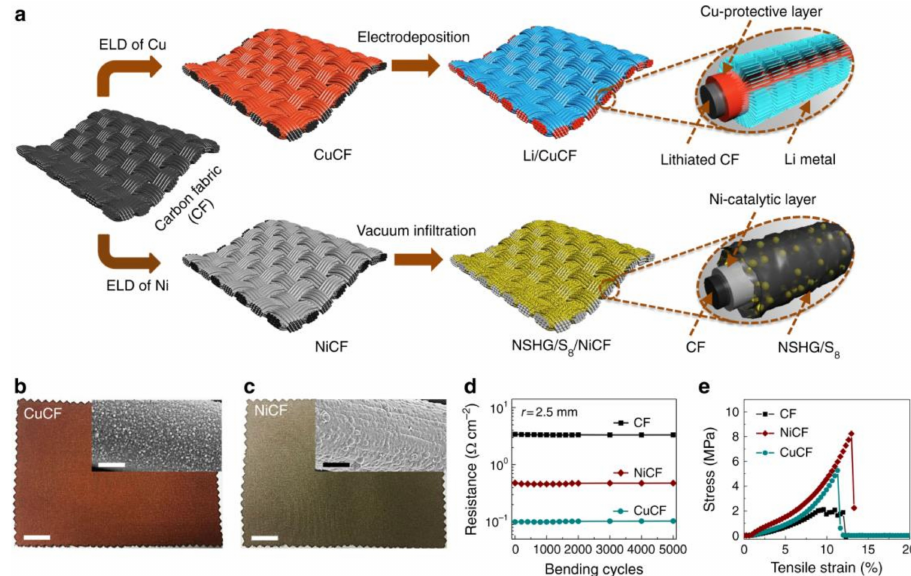
Figure 6. ( a ) Fabrication process of lithium and sulfur electrodes from carbon fabrics (CF); ( b , c ) digital (scale bar = 3 cm) and SEM (scale bar = 3 µ m) photographs of CuCF and NiCF electrodes; ( d ) CF, NiCF, CuCF resistances and ( e ) tensile stress–strain curves. Reproduced from reference [172] under CC BY 4.0